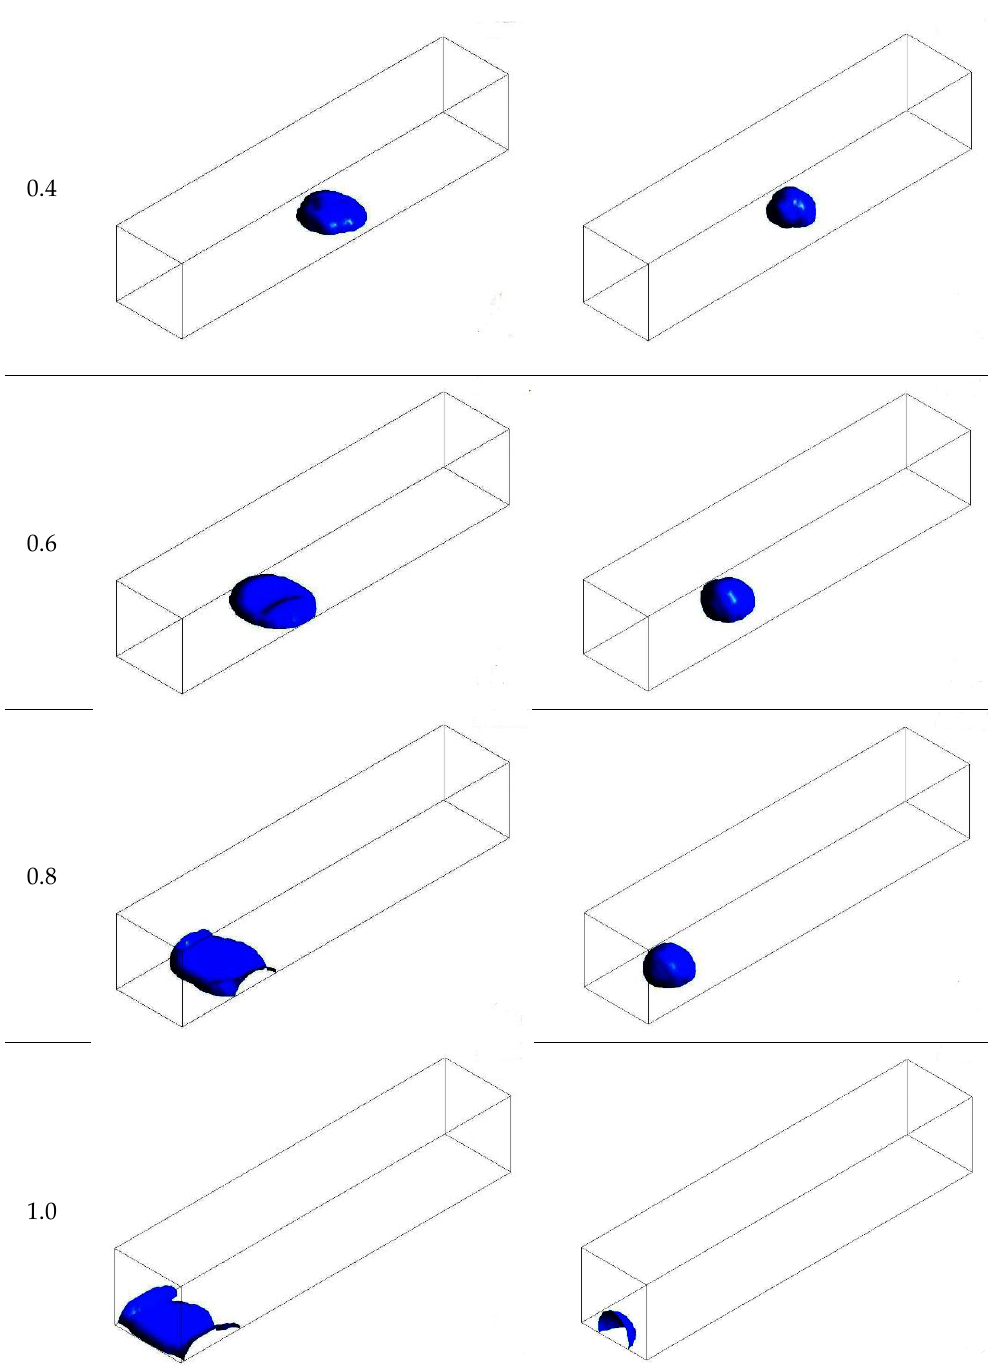
Figure 5. Time evolution of the water droplet (all the surface contact angles are 45° and all the surfaces contact angles are 135°).